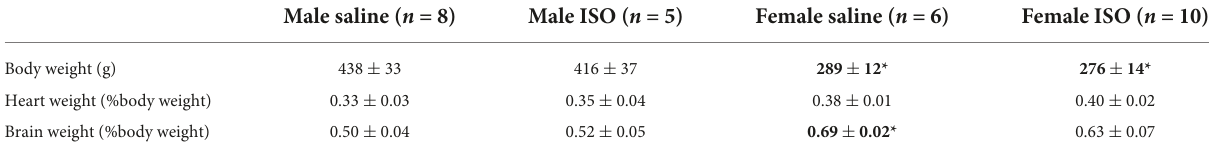
TABLE 1 Bodyweight at sacrifice and relative organ weight in the experimental groups.